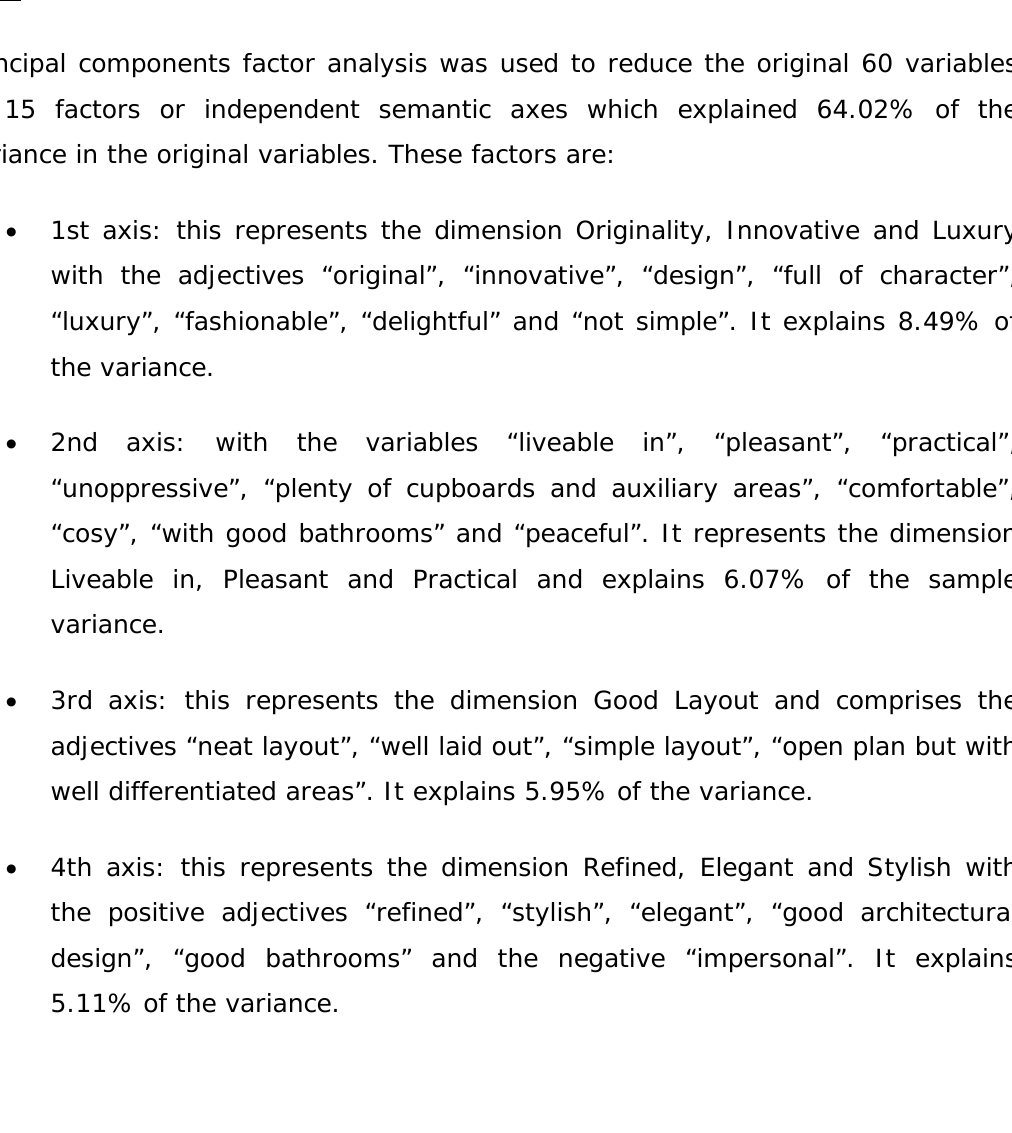
the positive adjectives “refined”, “stylish”, “elegant”, “good architectural design”, “good bathrooms” and the negative “impersonal”. It explains 5.11% of the